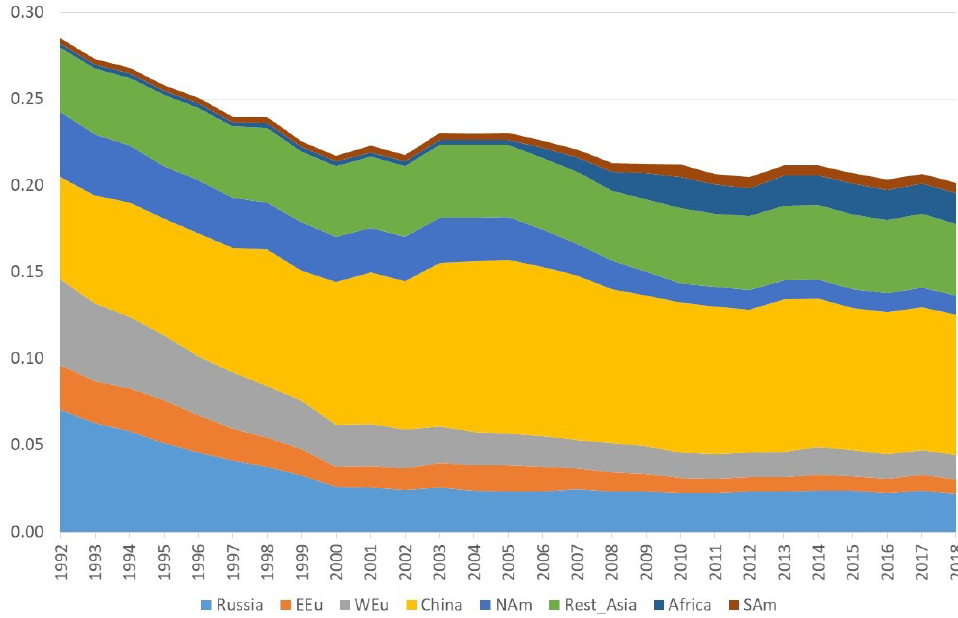
Figure 8. Model calculations with variable emissions of the source apportionment of the direct anthropogenic contribution to the annual average GEM concentrations at Villum. The DEHM model was used for 2 years (1990 and 1991) to spin up the model. Source regions: